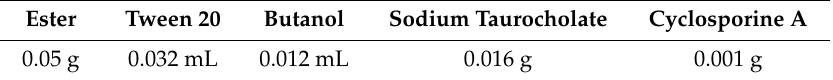
Table 2. Amount of reagent used in SLNs